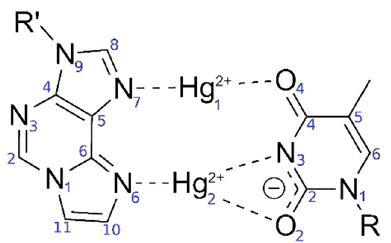
Figure 2. Originally proposed [52] bonding pattern of the dinuclear mercury(II)-mediated base pair between 1, N 6 -ethenoadenine ( ε A ) and thymine ( T ), including the atom numbering according to IUPAC recommendations in blue.